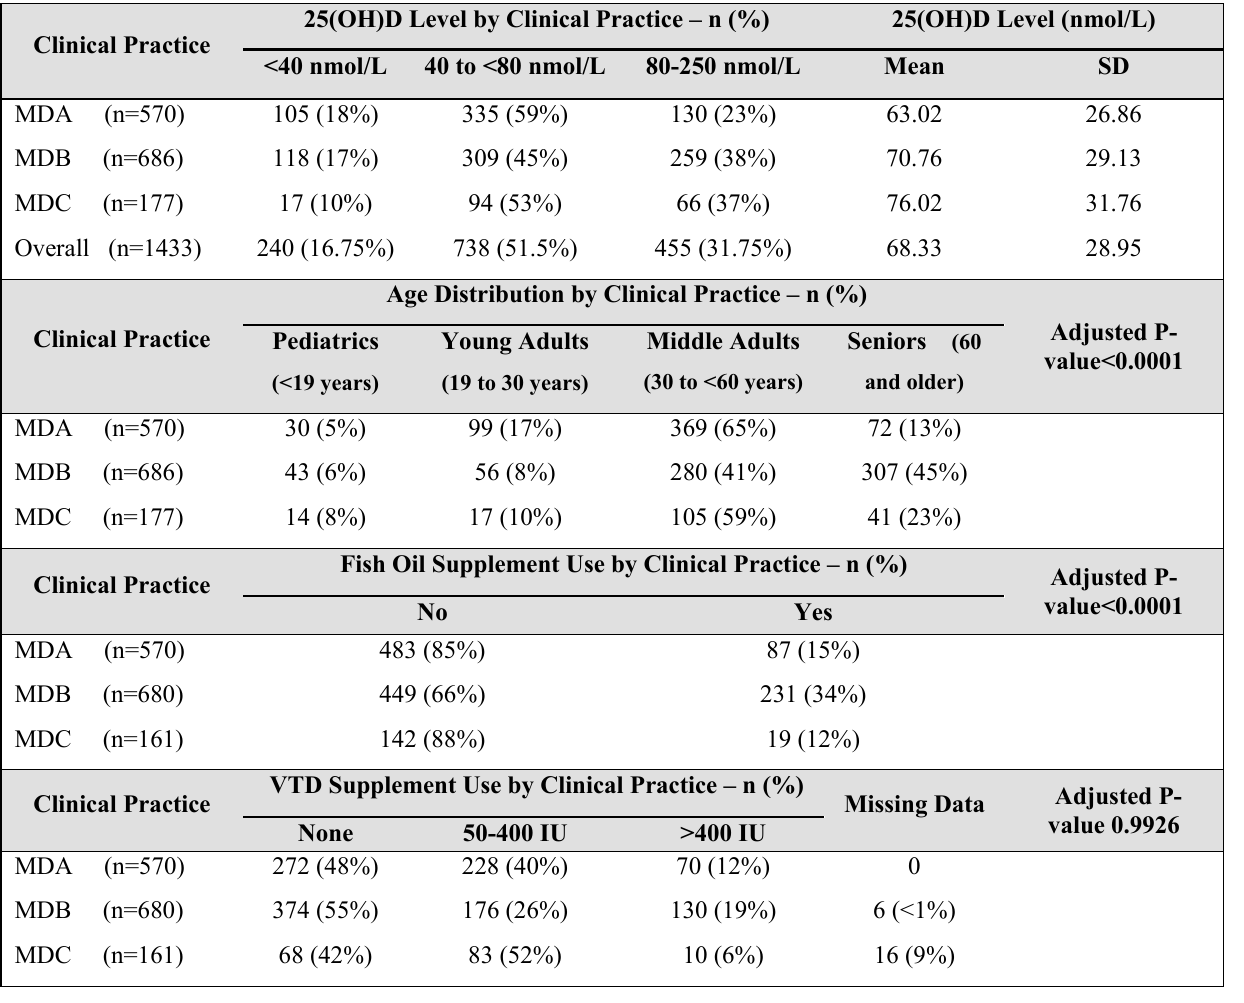
Table 2. VTD Status by Clinical Practice and Practice Comparison for Patient Age and Supplement